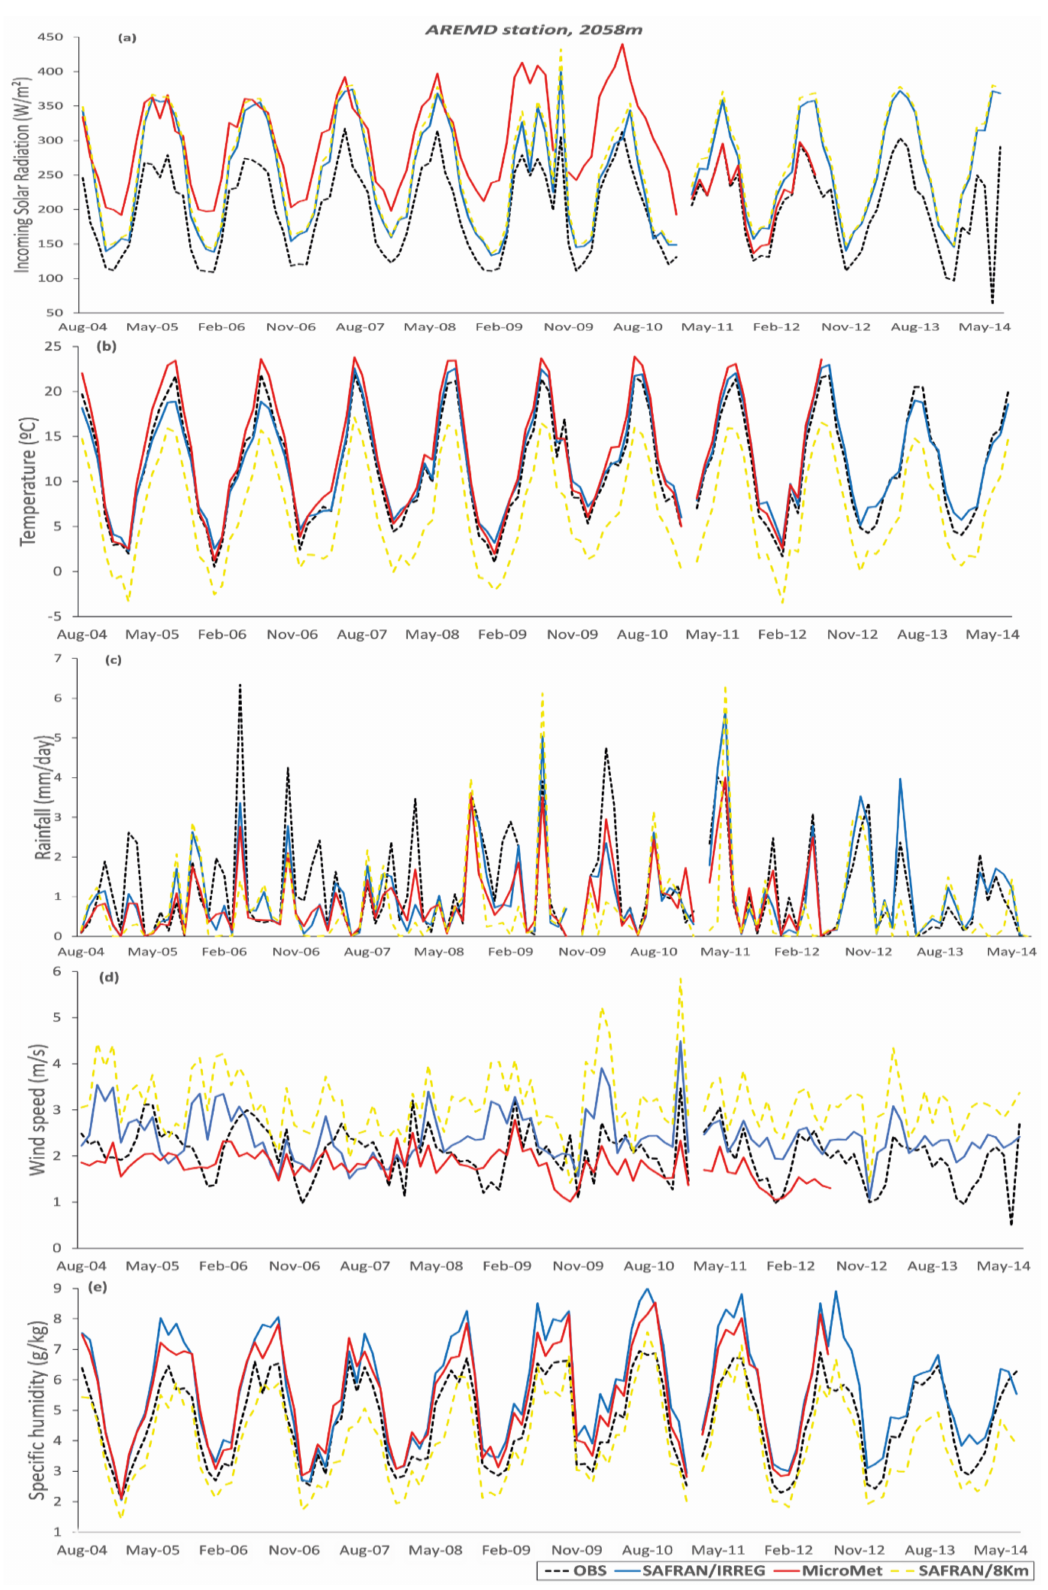
Figure 2. Comparison of the evolution of the reanalysis of SAFRAN (8 km and irregular) and MicroMet model with the observation at the Aremd station, for the period 2004–2014: ( a ) Incoming Solar Radiation; ( b ) Air temperature; ( c ) Rainfall; ( d ) Wind Speed; ( e ) Specific